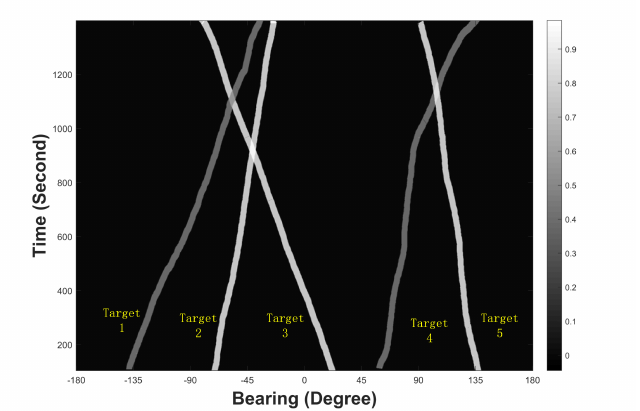
Figure 5. Original Bearing-Time